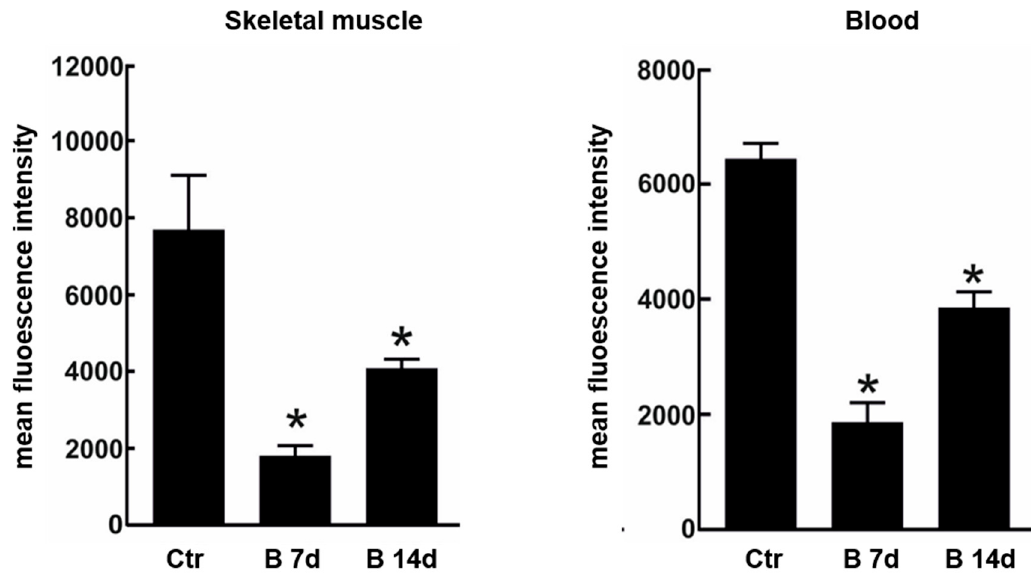
Figure 3. Chymotrypsin-like proteasome activity in skeletal muscle and blood of control mice and mice treated for 7 or 14 days with bortezomib. Chymotrypsin-like activity decreases significantly in skeletal muscle and blood of treated mice compared to control group. The graph presents mean fluorescence intensity ± SD; n = 3; * p < 0.05 vs controls in one-way Anova with Dunnet’s post hoc test.